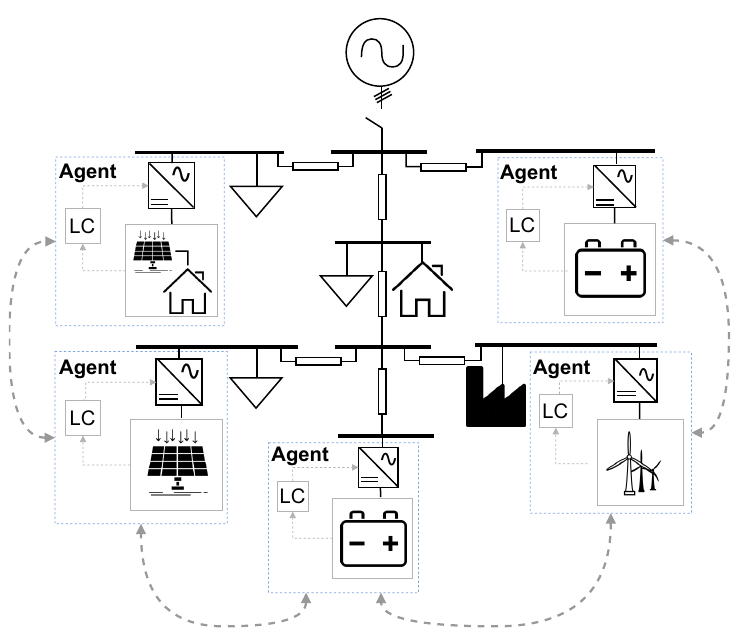
Figure 1. Distributed communication